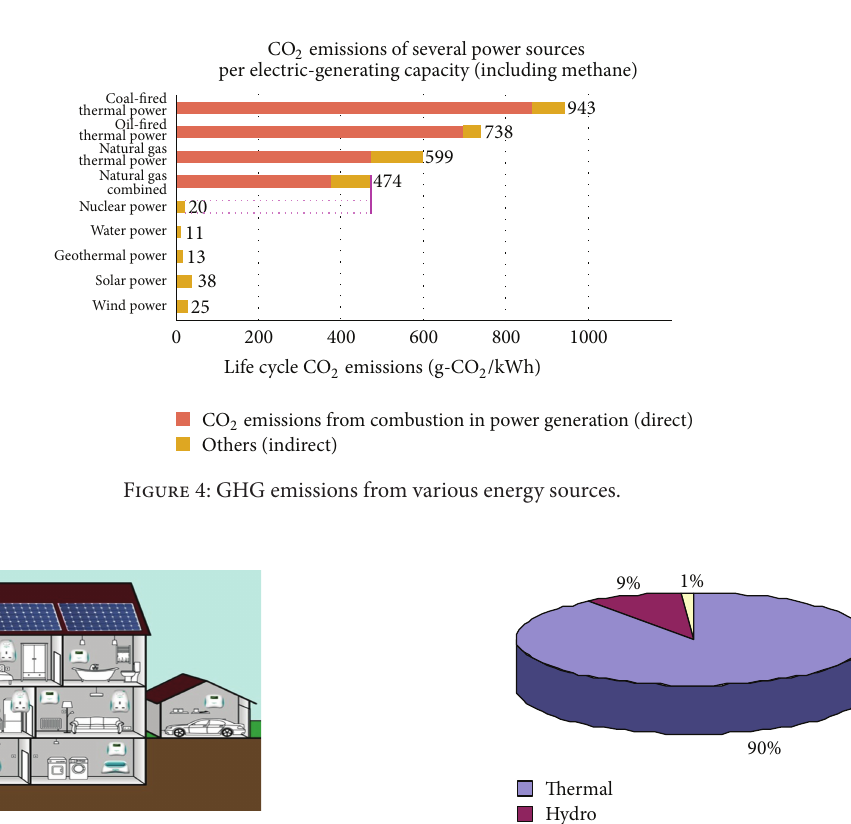
Figure 5: Smart home.